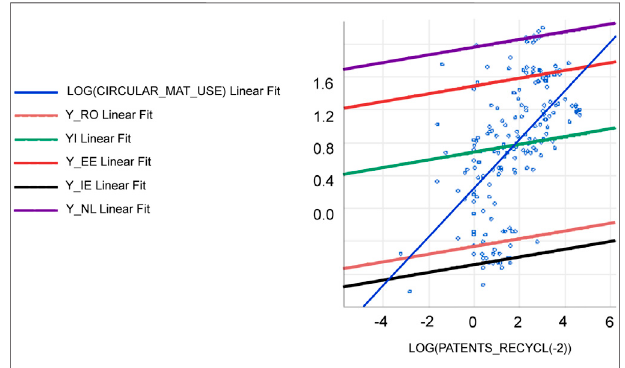
FIGURE 5 | Comparative regression lines for OLS model and Fixed Effect Model (FEM)/Source: own calculation.